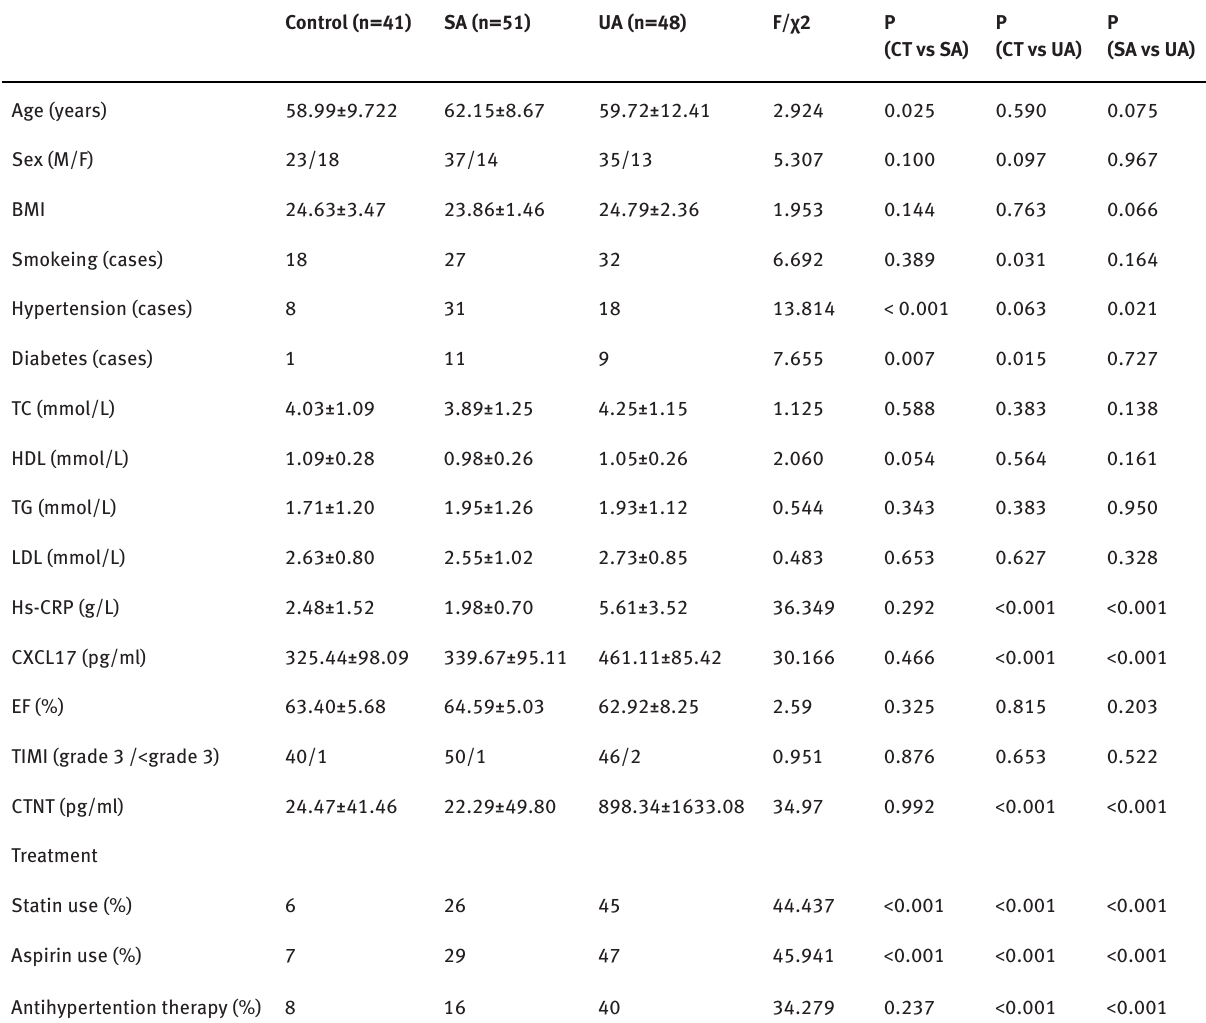
Table 1: Comparison of the characteristics between patients with SA, UA and control